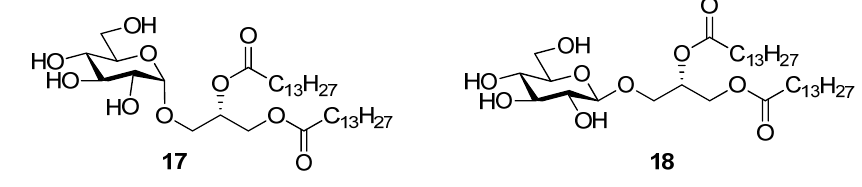
Figure 1. Glycolipids 17 ( α -monoglycolipid) and 18 ( β